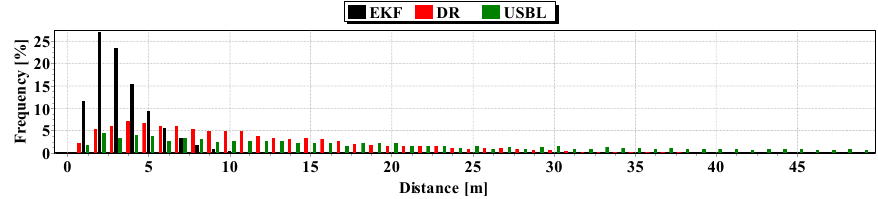
Figure 25. Graph of the reference position distance from the position estimated by EKF and DR methods and determined by the USBL system (hundred passages).